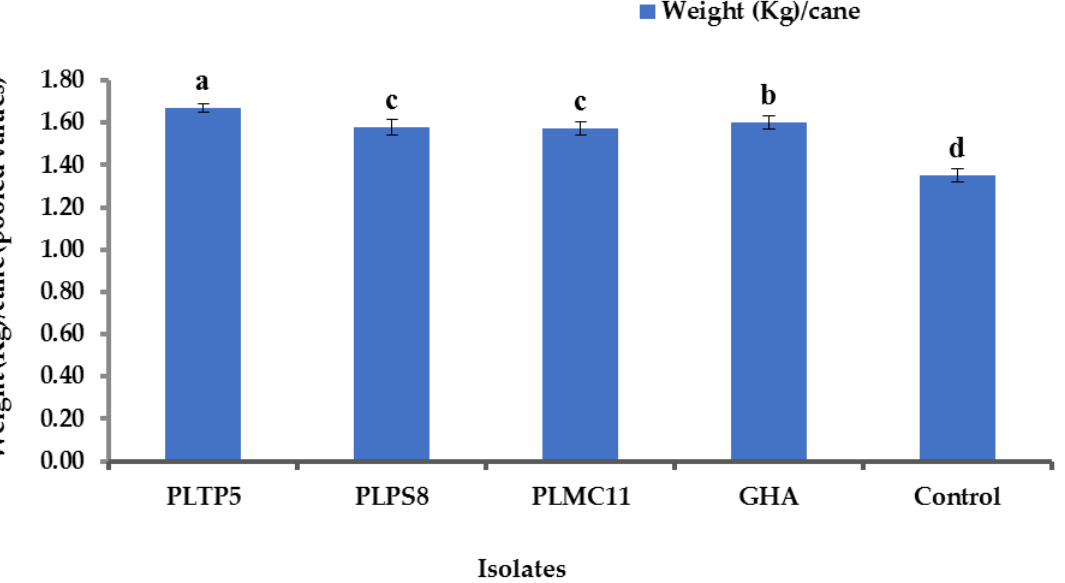
Figure 13. Effect of EPF conidia formulation application on the weight of sugarcane. Different letters (a–d) in columns indicate significant differences ( p ≤ 0.05) among the isolates. Columns represent the mean ± SD ( n = 3). SD = standard deviation.